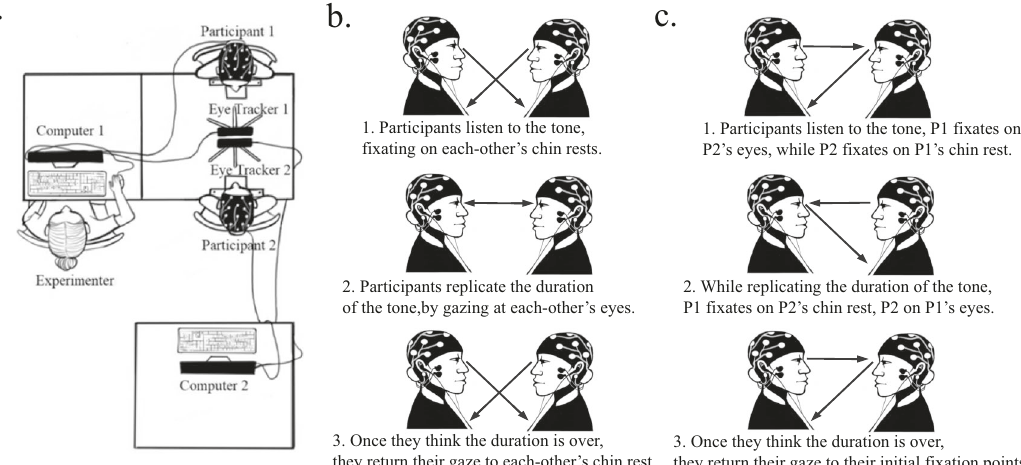
Fig. 1 Experimental setup and task. a Two computers were synchronized during the experiment and each computer collected EEG and eye-tracking data from one participant and received EEG and eye-tracking event markers with no delay (all centrally controlled through Matlab). b Eye-contact time estimation task: participants were required to reproduce the duration of a tone delivered through headphones without speaking to their dyadic partner. Eye- contact condition: during the delivery of the tone, participants were instructed to fi xate on a sticker on the other participant ’ s chinrest. After the tone ended, participants were instructed to look at the other ’ s eyes for the duration of the tone, looking back down to indicate that they fi nished reproducing the tone duration. The tones were either long (2.5 s) or short (1.5 s). c No eye-contact control condition: participants replicated the duration of the tone but never made eye contact. Participant A listened to the tone while fi xating on their partner ’ s eyes while participant B listened to the tone while fi xating on their partner ’ s chinrest. After the tone, both participants replicated its duration, participant A by fi xating their partner ’ s chinrest ( fi xation point marked with a dot sticker) and participant B by fi xating their partner ’ s eyes. To indicate the end of the tone interval, each participant reverted their gaze back to the starting position. In one block, participant A replicated the duration by looking at their partners ’ chinrest and the other by looking at participant B ’ s